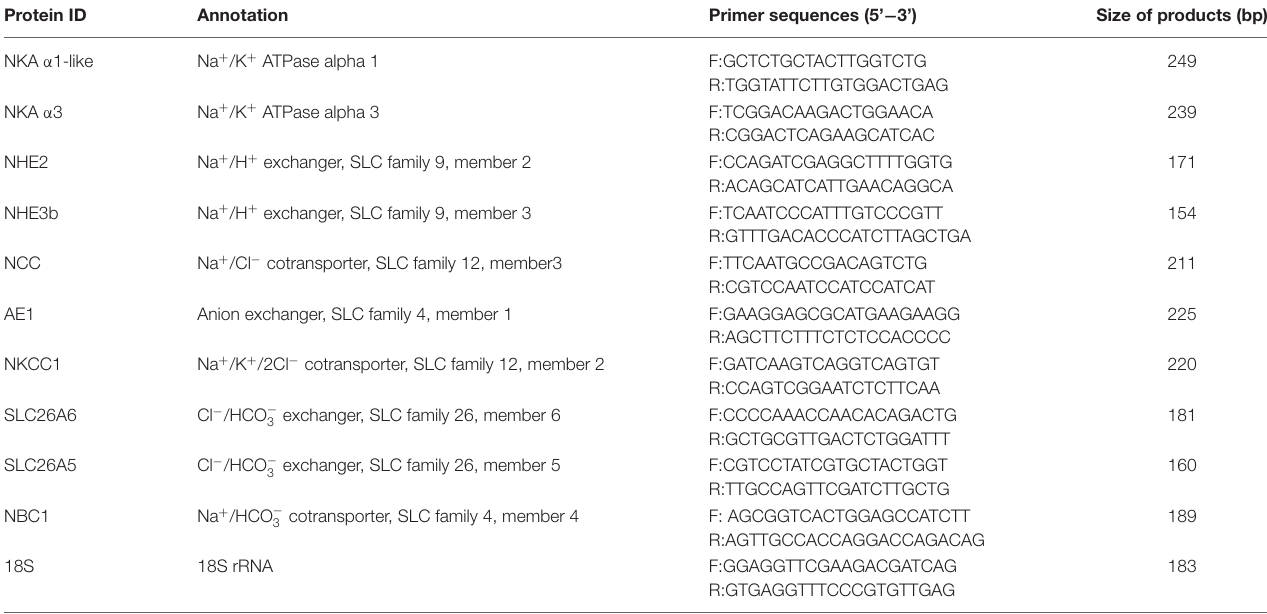
TABLE 1 | Information on the primer pairs used to quantify expression of genes via RT-qPCR. RT-qPCR: quantitative real-time PCR. Protein ID